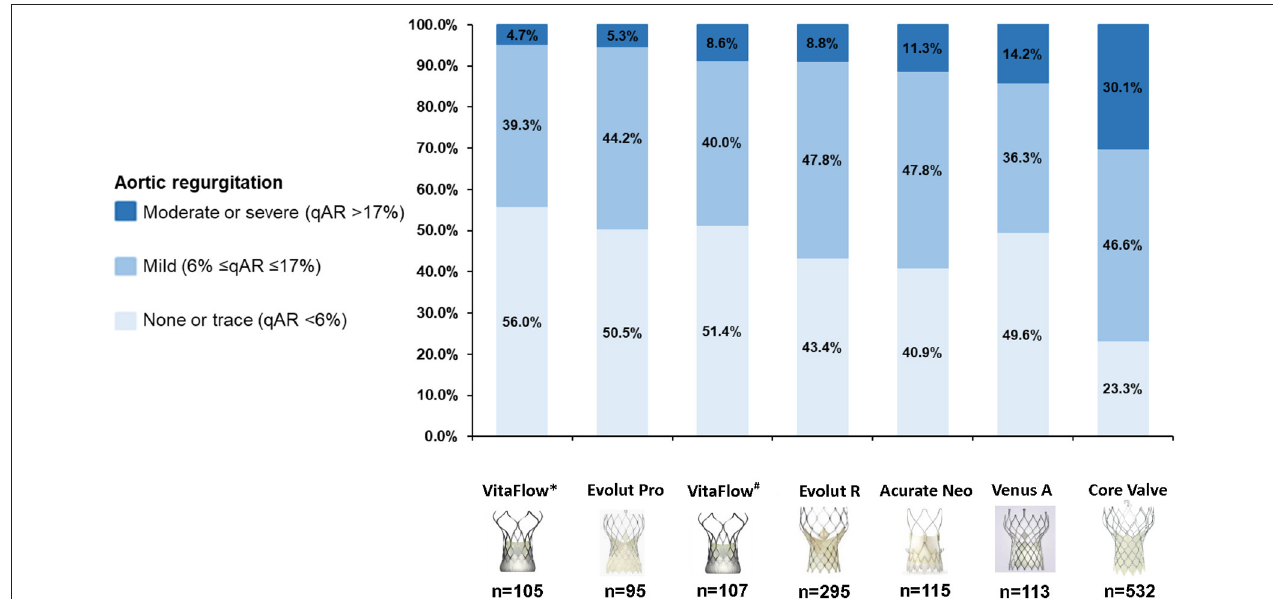
FIGURE 3 | Cumulative percentage of different degrees of post-TAVR AR by videodensitometric assessment. VitaFlow*: the analysis of LVOT-AR using the final aortograms (after the second valve implantation), VitaFlow # : the analysis of LVOT-AR using the intermediate aortograms. AR, aortic valve regurgitation; TAVR, transcatheter aortic valve replacement.